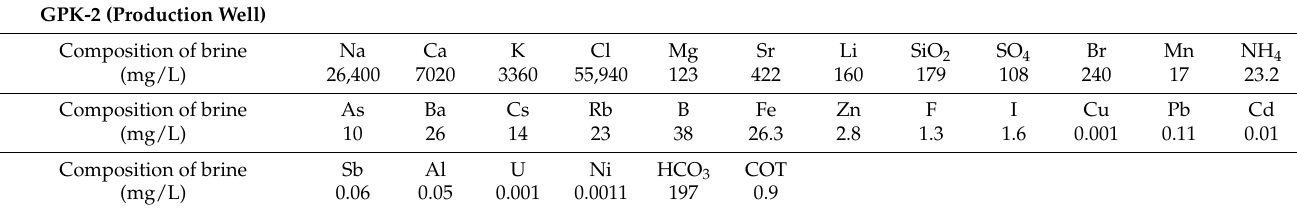
Figure 2. The SsF geothermal power plant (Source: EEIG Heat Mining). The geothermal brine is flowed through a system that consists of three consecutive double pass tubular heat exchangers which supply heat to an Organic Rankine Cycle (ORC) to produce electricity. The geothermal brine is then fully reinjected into the granitic basement at around 65–70 ◦ C. The volume of reinjected brine is split between the two injection wells without the need of reinjection pumps. The well-head overpressure in the surface infrastructure is regulated by using production pump which reaches about 23 bars to keep the gas dissolved in the brine. The reinjection temperature is linked to the conversion process. The geothermal plant has been successfully producing electricity commercially since September 2016, with an availability rate of about 90% for the past four years [6]. The granite reservoir is made of a porphyritic monzogranite rich in K-feldspar megacrysts. Primary silicate minerals are quartz, plagioclase, biotite, and hornblende. A chemical analysis on the composition of the brine was taken in February 2020 (Table 1, [7]), while an analysis on the gas dissolved in the brine was taken in April 2019 (Table 2, [7]). Table 1. Composition of brine at the production well of the SsF geothermal plant [7].